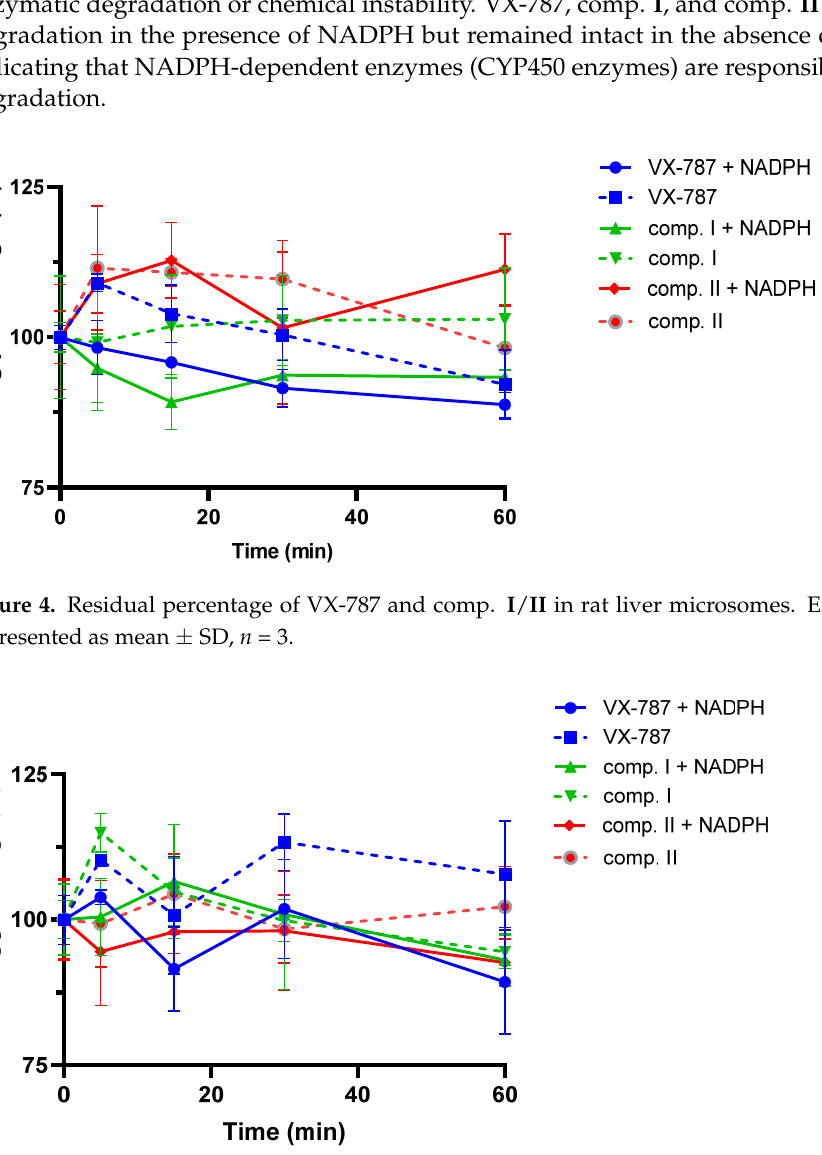
Figure 5. Residual percentage of VX-787 and comp. I / II in human liver microsomes. Error bars are represented as mean ± SD, n = 3.